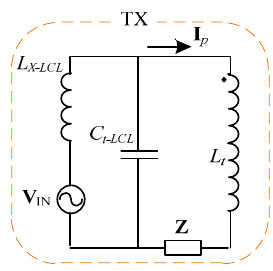
Figure 5. Schematic diagram of the LCL topology.